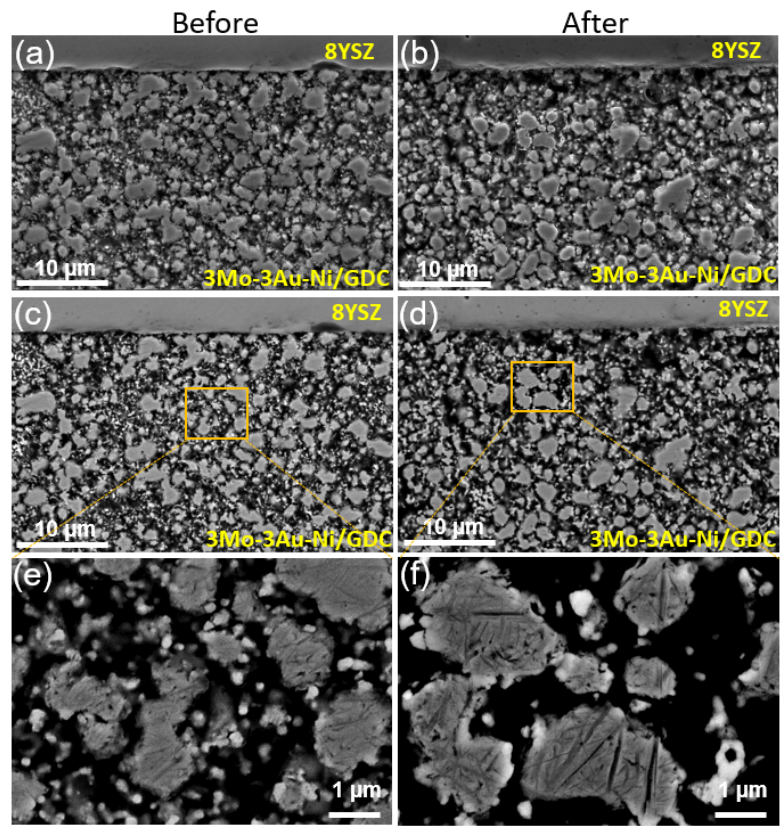
Figure 6. SEM images of fuel electrode sides for 3Mo-3Au-Ni-GDC/8YSZ/GDC/LSCF single cells ( a , c , e ) before and ( b , d , f ) after 1700 h steam electrolysis operation at 900 °C with 63 vol.% H 2 O + 30 vol.% N 2 + 7 vol.% H 2 feed gas mixture and − 0.3 A ‧ cm − 2 current load. ( a , b ) were taken using a secondary electron detector, while ( c – f ) were taken using a backscattered electron detector. In ( c – f ), the bigger grey grains are Ni, and bright fine particles are GDC. ( f ) The coverage of Ni particles by GDC.